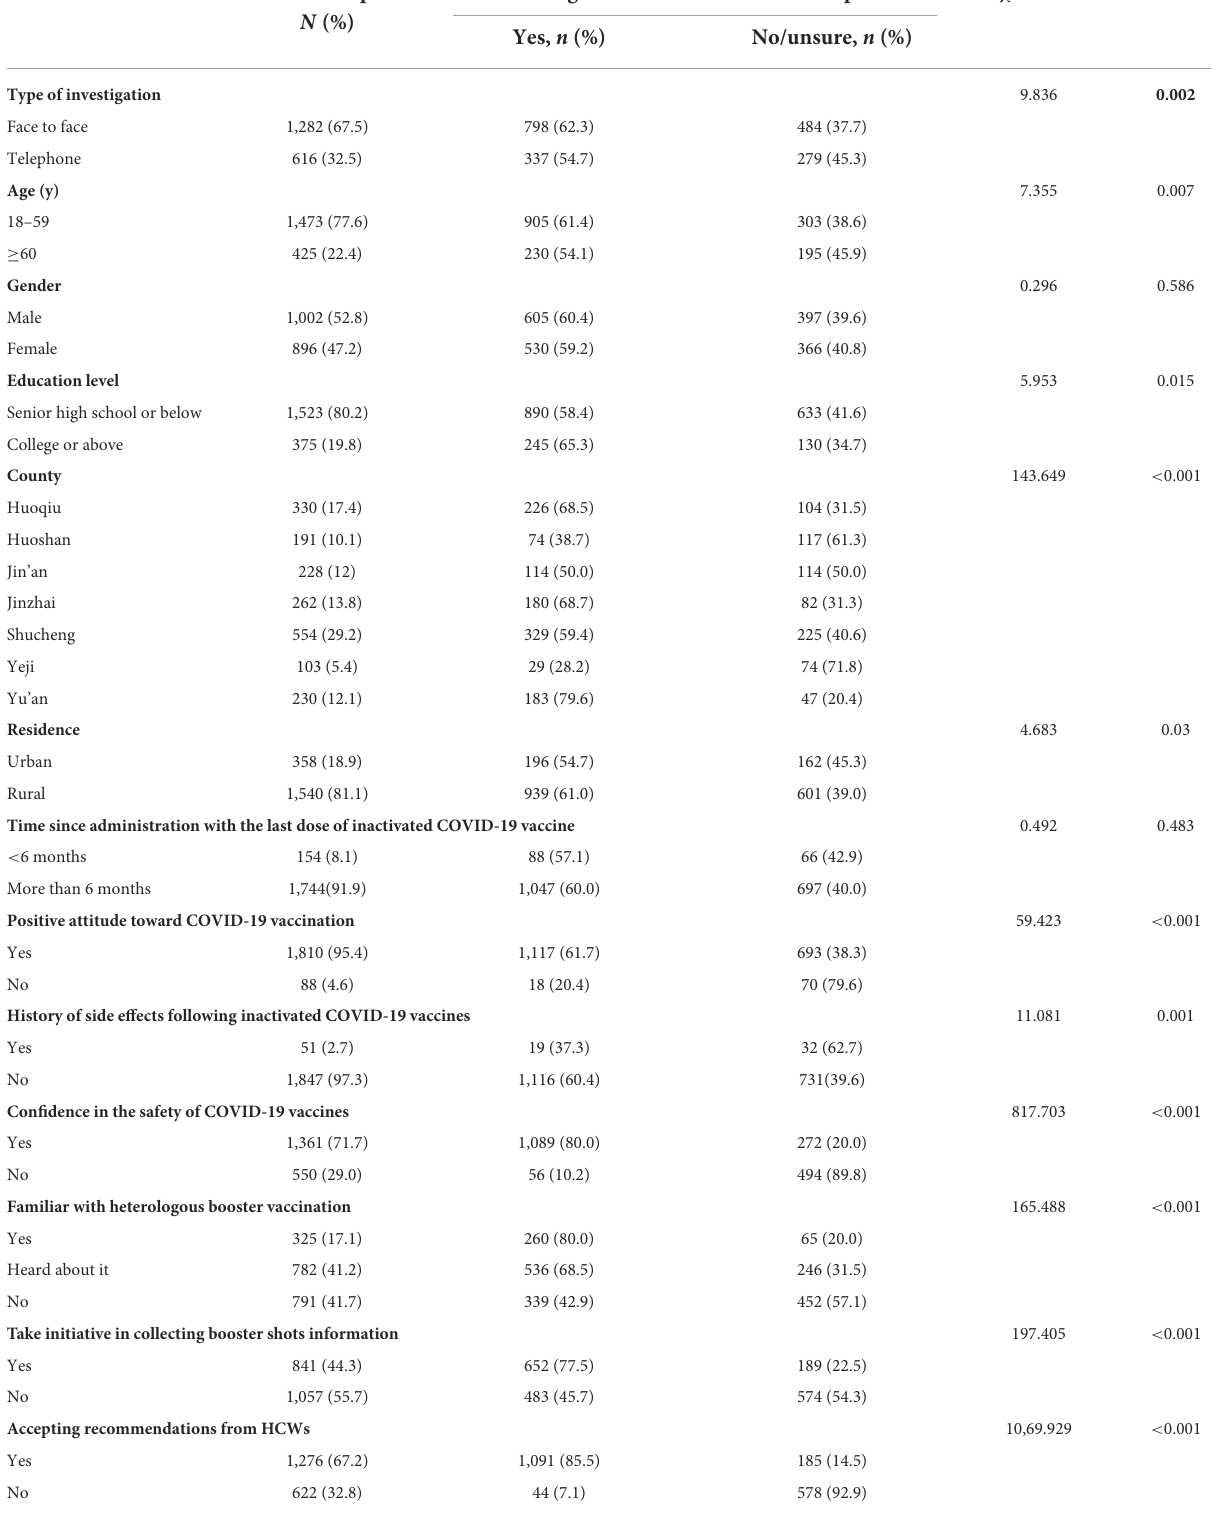
TABLE 2 Characteristics of respondents and their acceptance of heterologous booster vaccination against COVID-19 ( N =